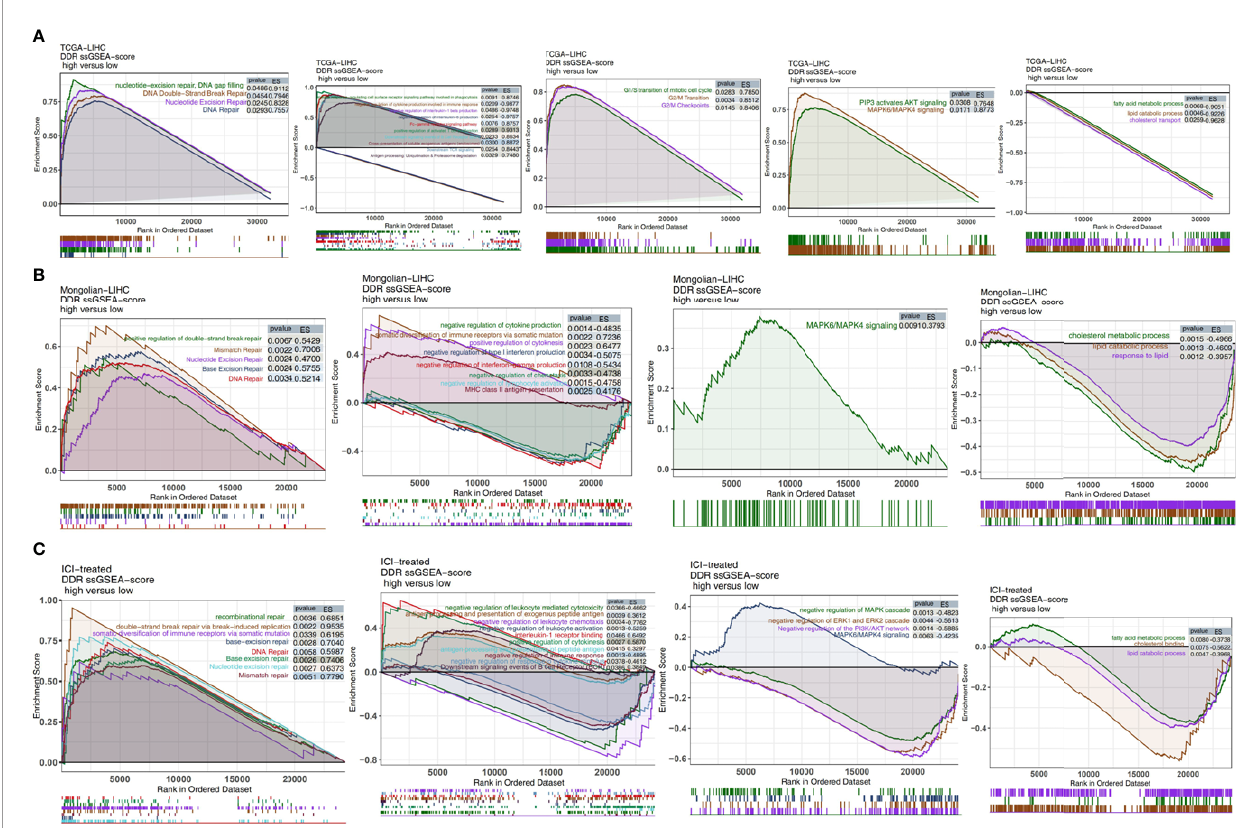
FIGURE 7 | Biological function pathways, such as DNA repair, immune-related, cell cycle, drug resistance, and immune exhaustion pathways, identi fi ed as enriched between high DDR score and low DDR score tumors in the TCGA-LIHC cohort (A) , Mongolian-LIHC cohort (B) and ICI-treated cohort (C)